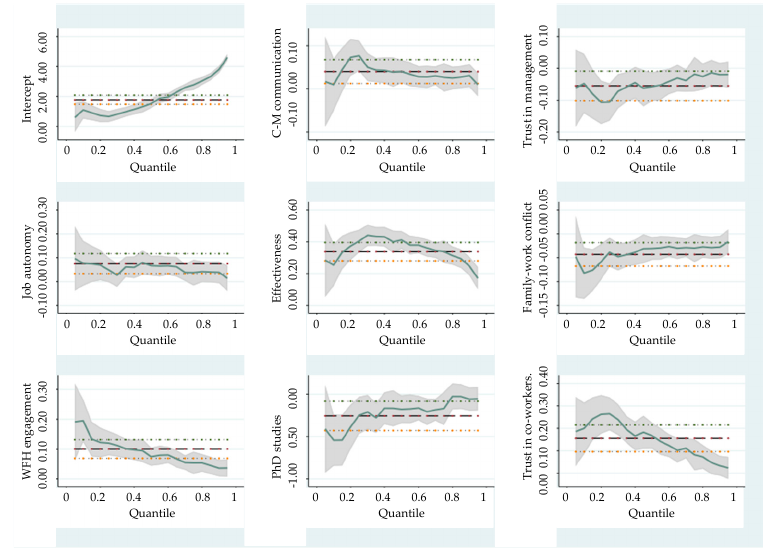
Figure 3. OLS and QR estimates for social performance model.